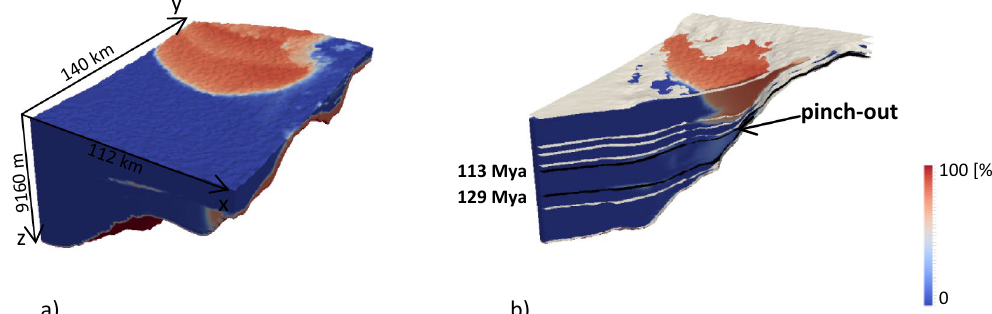
Figure 10. Three-dimensional representation of the exceedance probability Pr ( V sand > 20% ) evaluated over the sample of 500 calibrated solutions ( a ) and diagonal cross section of the same quantity together with the Z ∗ surfaces associated with available data in black and white ( b